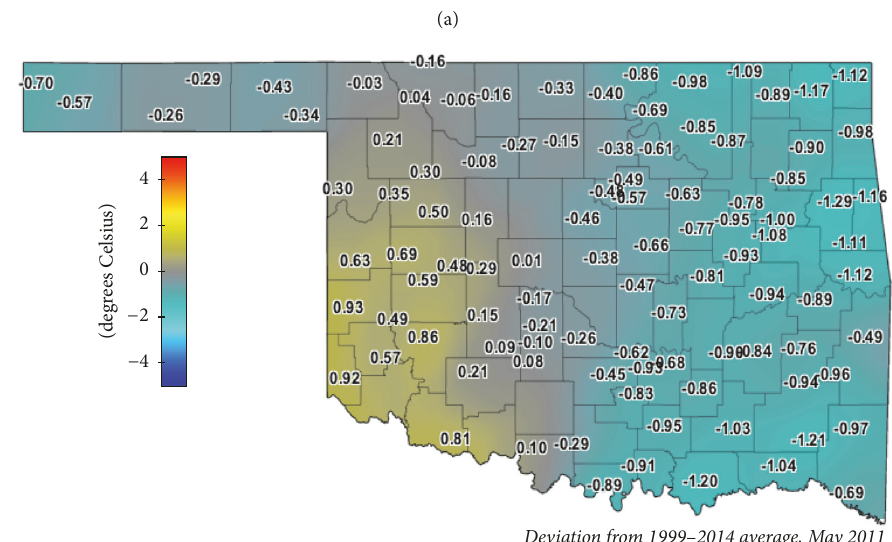
Figure 6: Same as Figure 4, except for average air